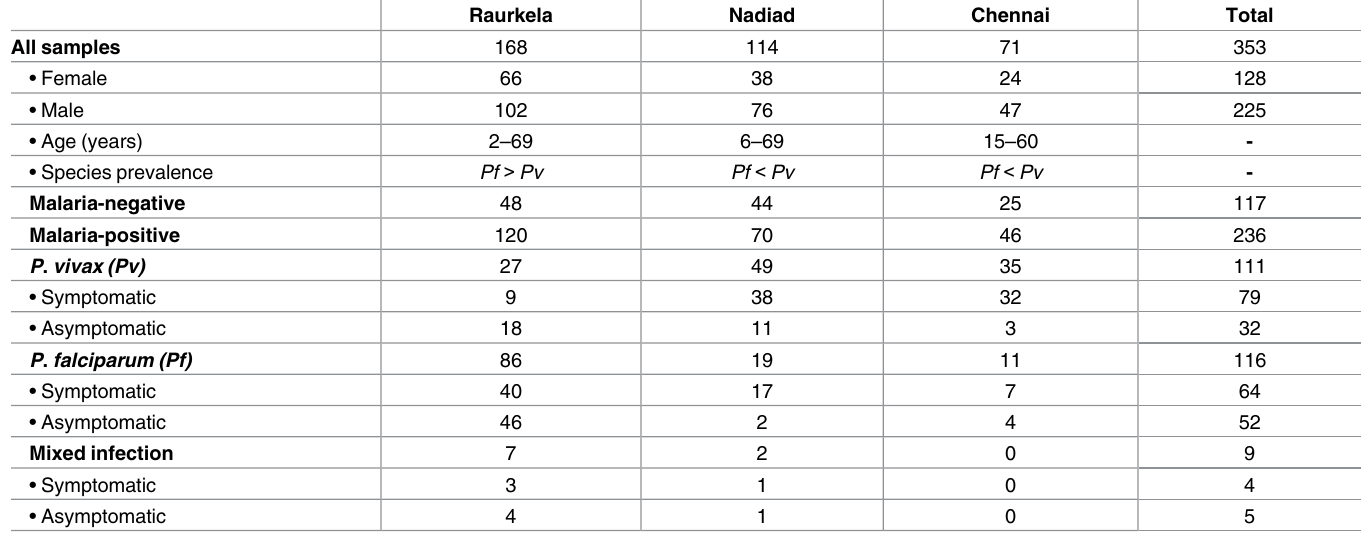
Table 1. Summaryof 353 samples collected at three sites in